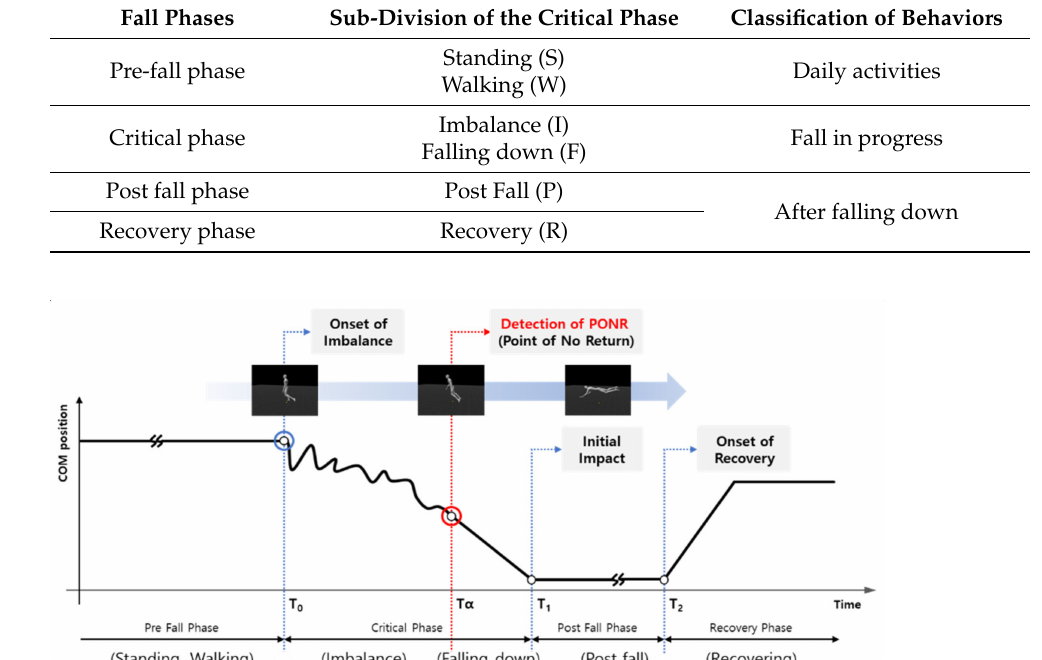
Table 1. Sub-division of the critical phase among the entire phases of the fall progress.